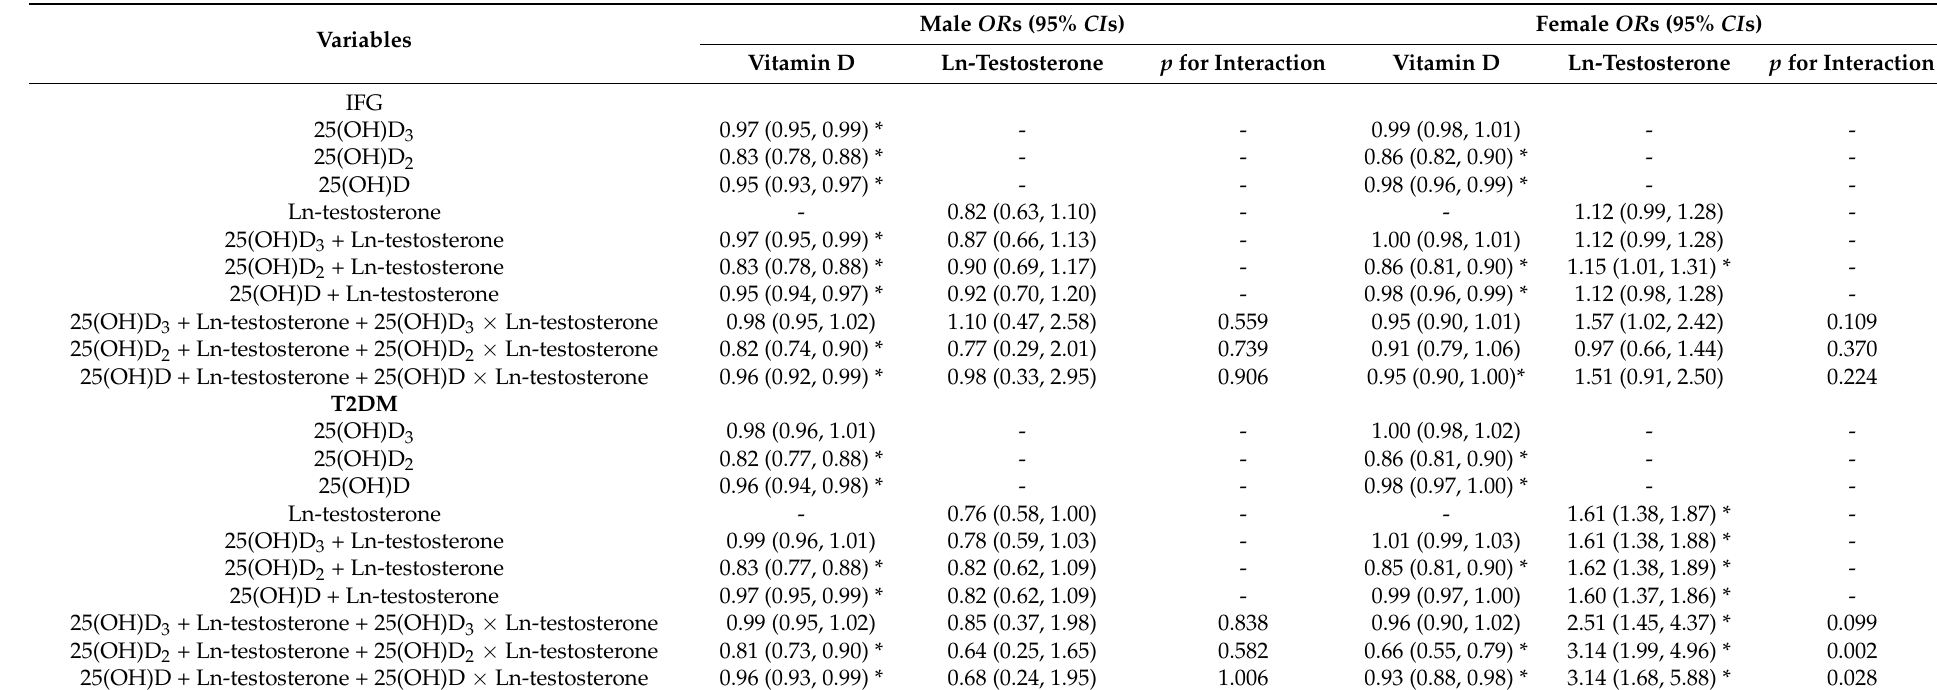
Table 2. The multiplication interactive effects of 25(OH)D 3 , 25(OH)D 2 , or total 25(OH)D and testosterone on IFG and